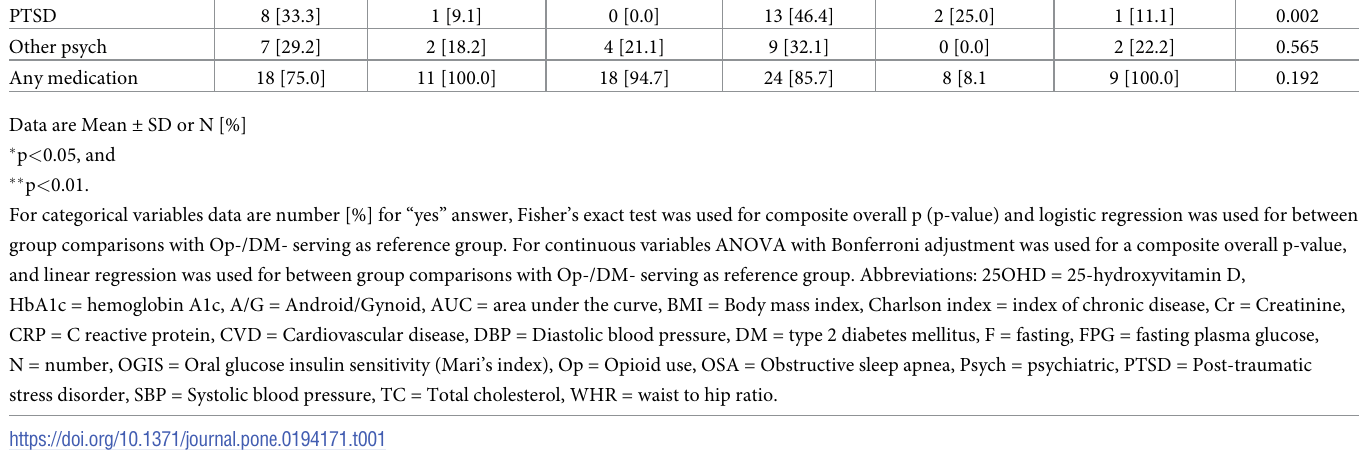
+ 52 vs. 136 for Catenibacterium and 128 vs. 197 for Parabacteroides (p < 0.05 for both), respec- tively. Changes in specific genera associated with T2D, without metformin (e.g., Dialister and Lachnospira ), were clearly distinct from those of metformin use (e.g., Catenibacterium , and Parabacteroides ).